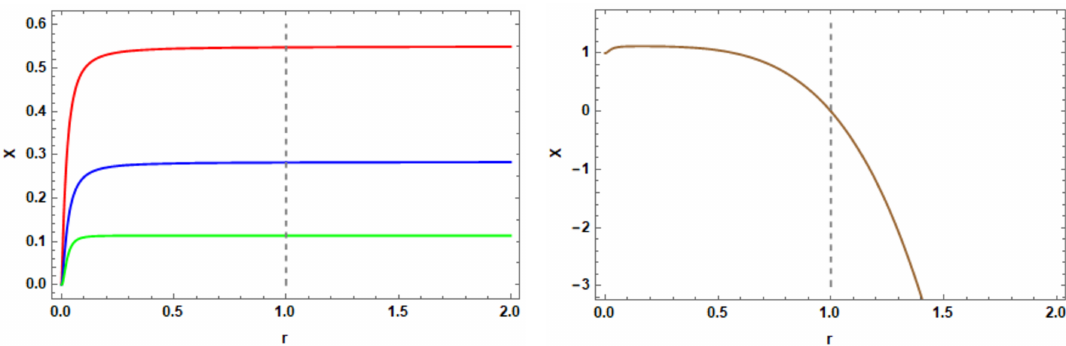
Figure 7. A flow from AdS to Kasner universe for φ 1 ( r h ) = 1 This corresponds to deformation A 1 φ 1 ( r ) , φ 3 ( r ) and χ ( r ) . For the right figure X = log g 0 represents the position of horizon, r H .